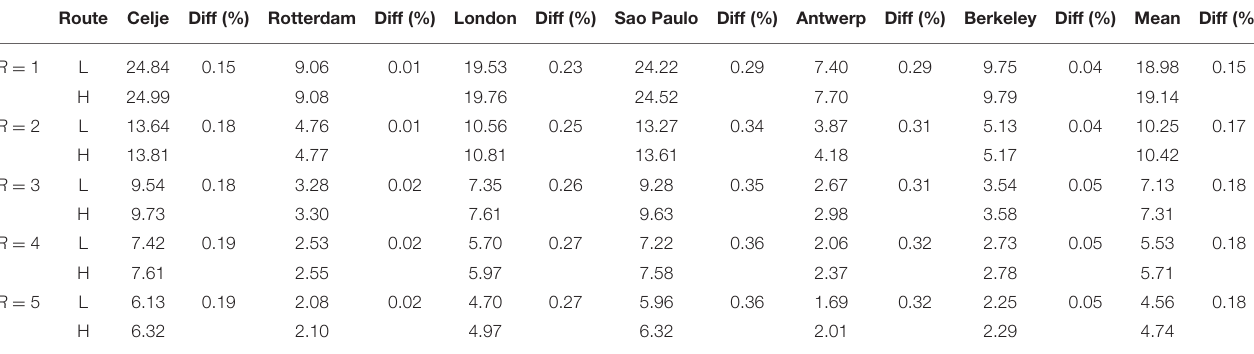
TABLE 4 | Estimated attributable proportion by taking the routes based on the measured black carbon (Diff = difference in attributable proportion, L = low exposure, H = high exposure